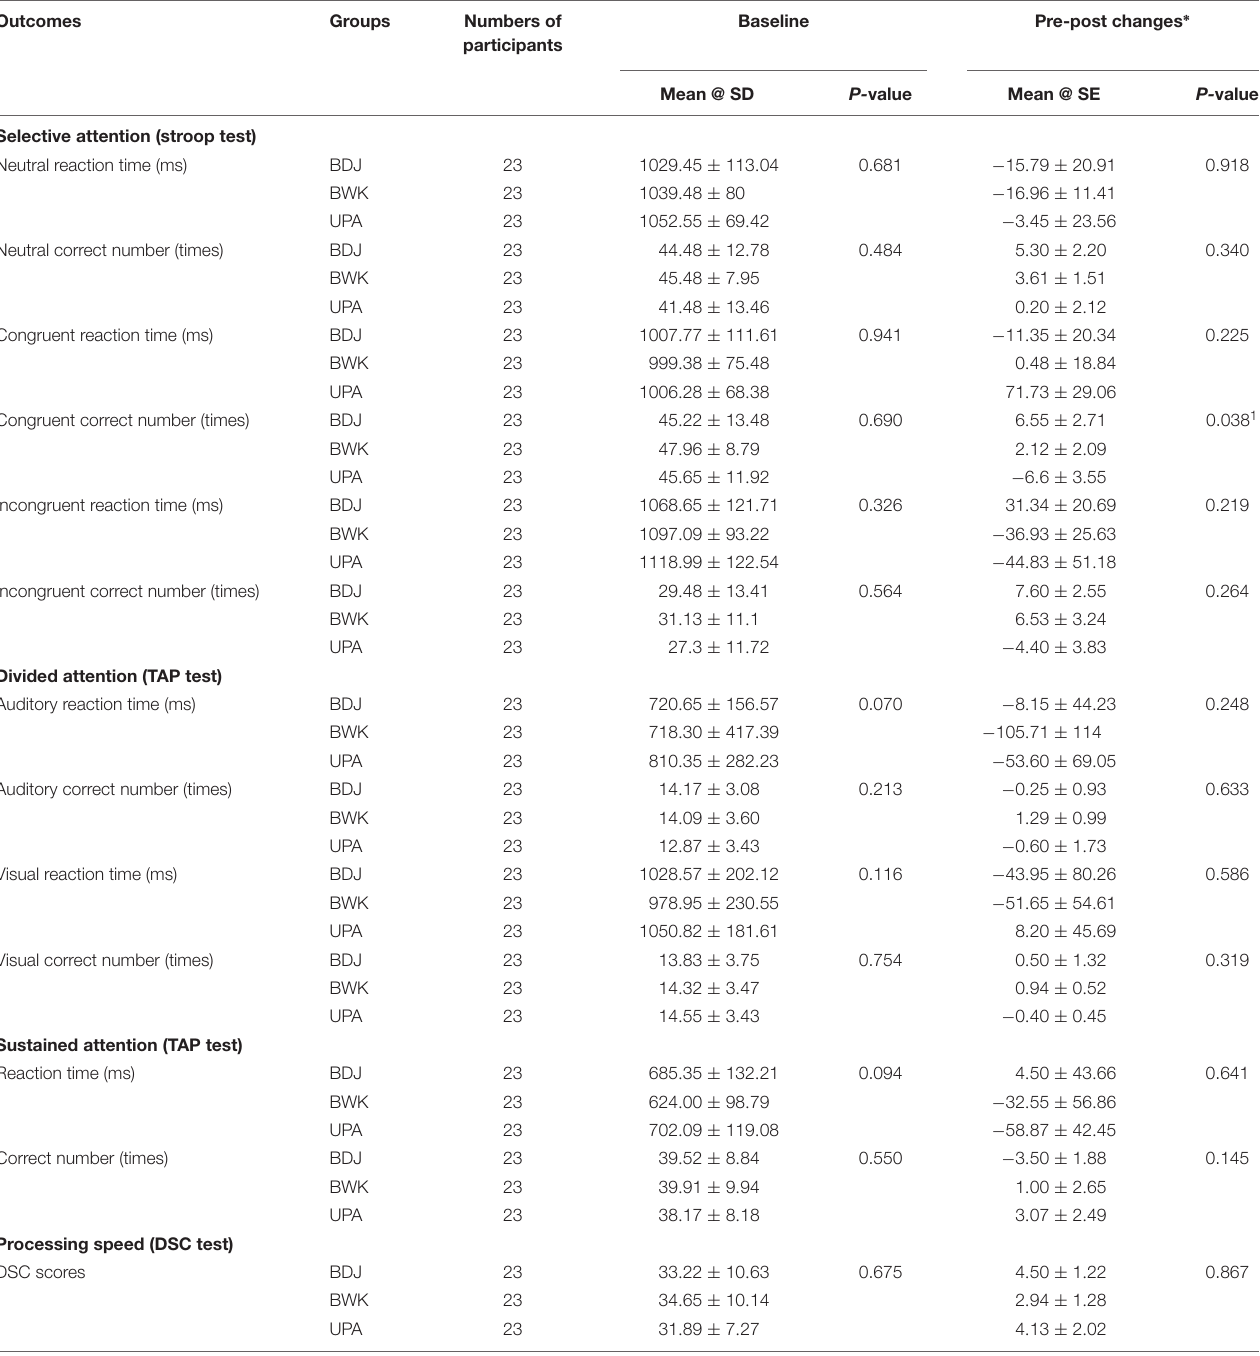
TABLE 2 | Comparison of attention ability among